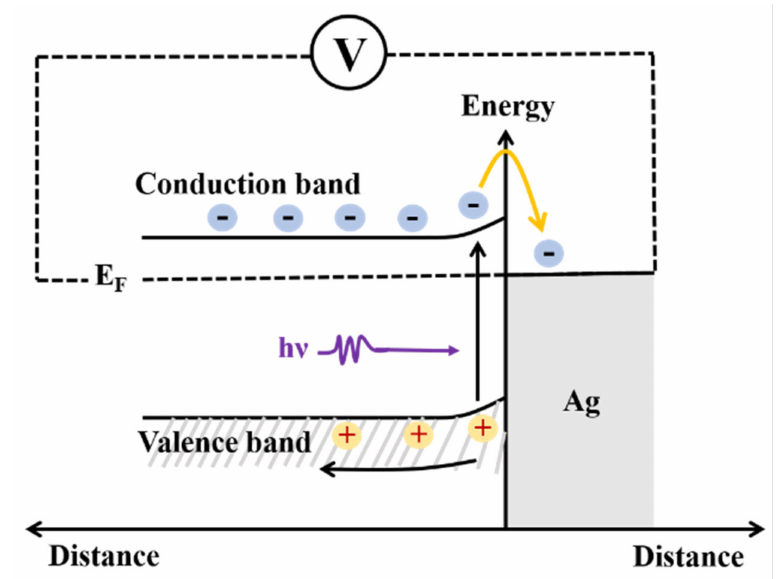
Figure 8. The model of the pyrite interface proposed in this